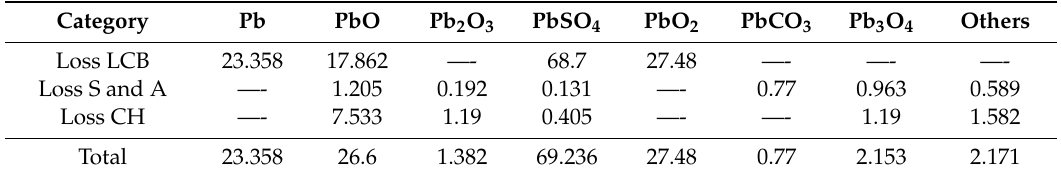
Table 6. The loss of various lead compounds in China’s lead waste management stage in 2017. (unit: kilo tons).